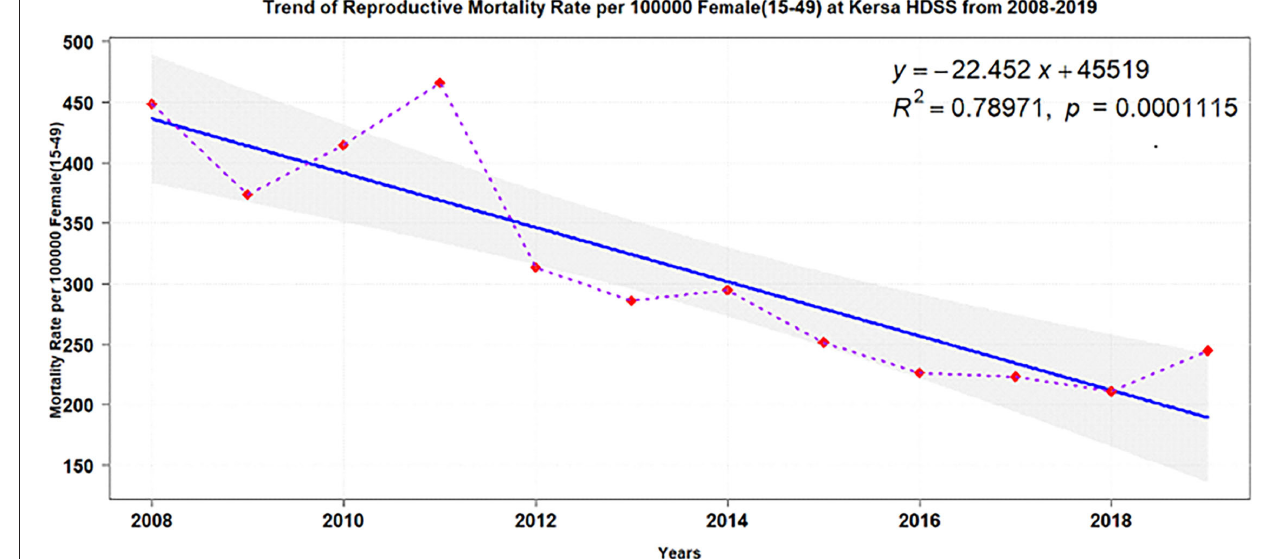
FIGURE 2 | Trends of women reproductive age mortalities in KHDSS, eastern Ethiopia (2008-2019).